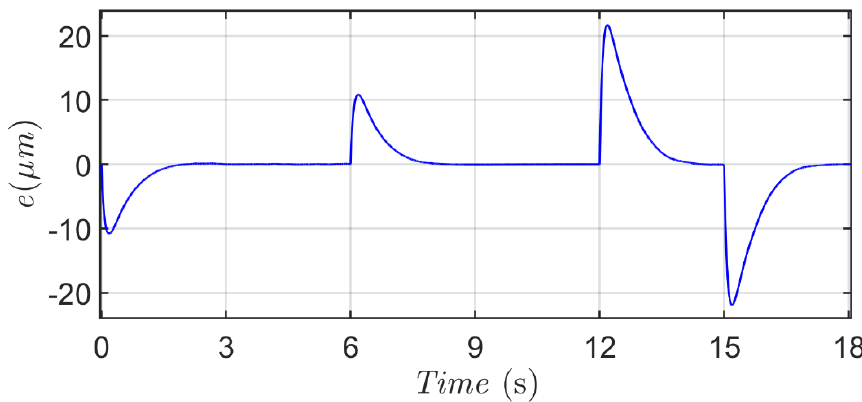
Figure 18. Micro-positioning error for a desired trapezoidal-type trajectory .